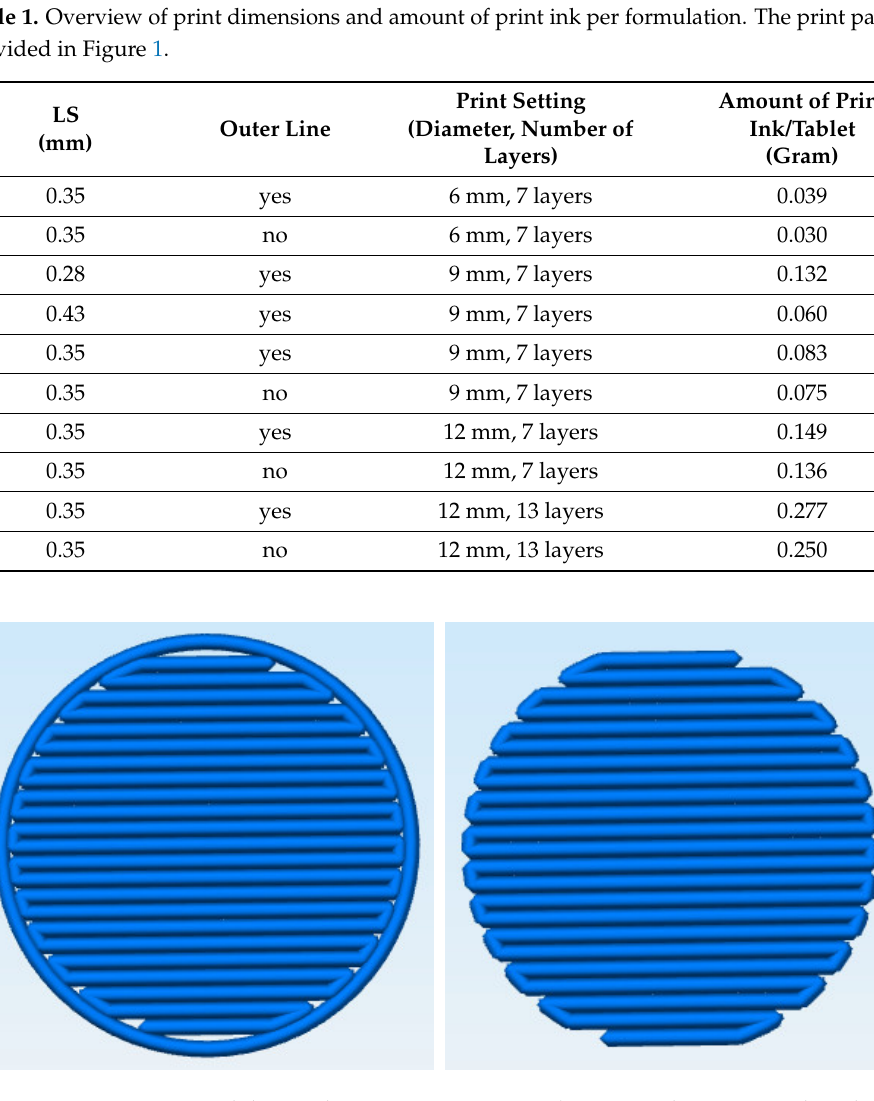
Figure 1. Print pattern used during the printing process. Left : an outer line is printed on the rim of tablet before the tablet is filled in line-wise direction. Right : no outer line is printed, and circle is being filled directly in a line-wise